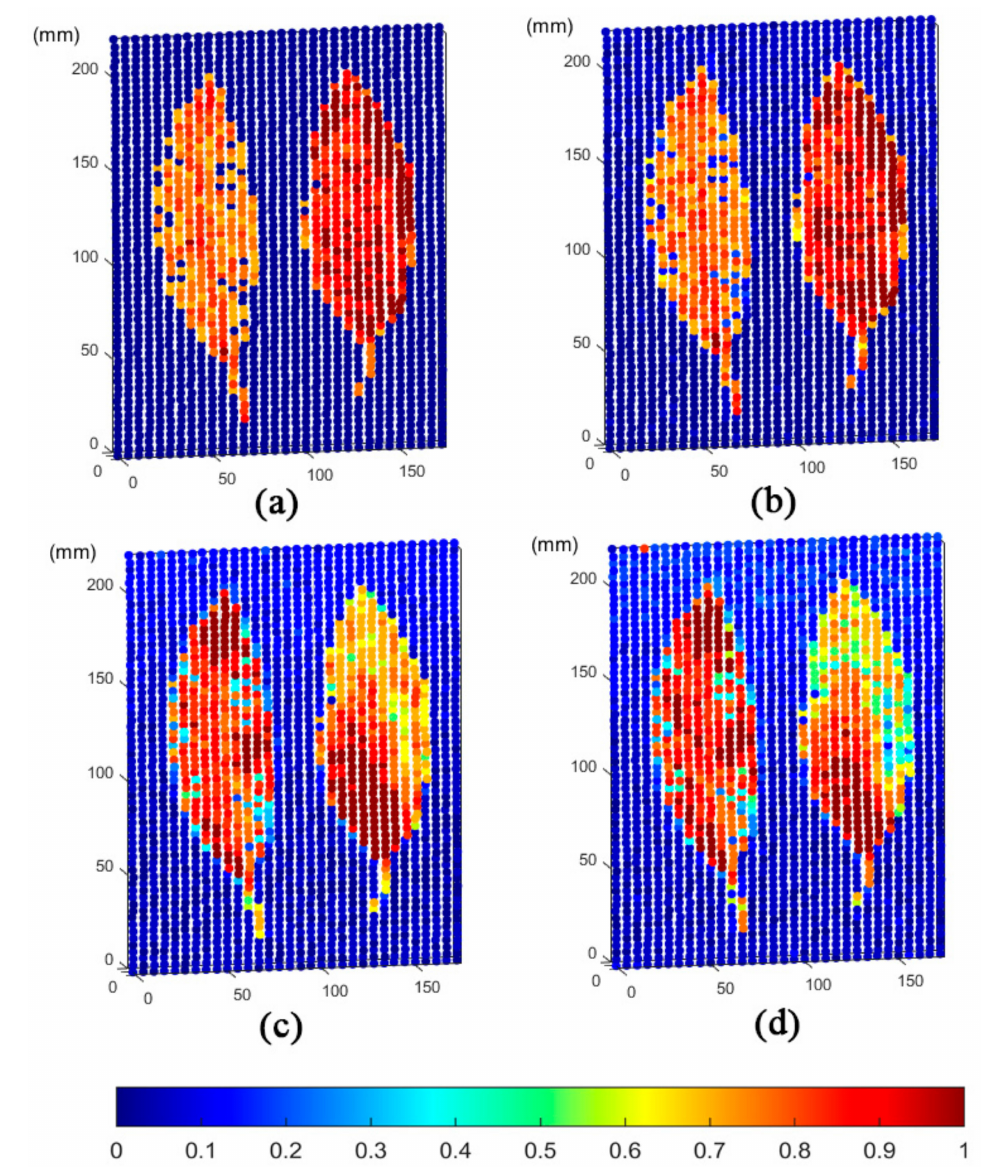
Figure 5. Single-wavelength fluorescence 3D imaging based on scene 1 scanning experiment of the MWFL system: ( a ) 460 nm, ( b ) 525 nm, ( c ) 685 nm, and ( d ) 740 nm wavelength signal intensity pseudo-color 3D imaging. The intensity values were subjected to histogram equalization (HE) and